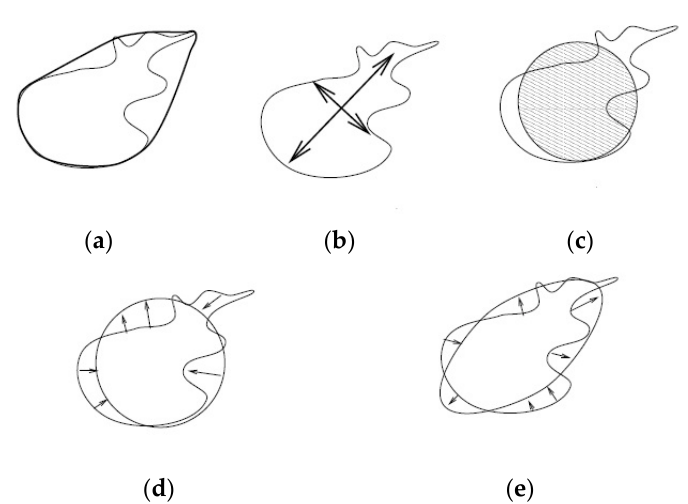
Figure 4. Local geometric feature descriptors: ( a ) convexity; ( b ) eccentricity; ( c ) compactness; ( d ) circle variance; and ( e ) elliptic variance.